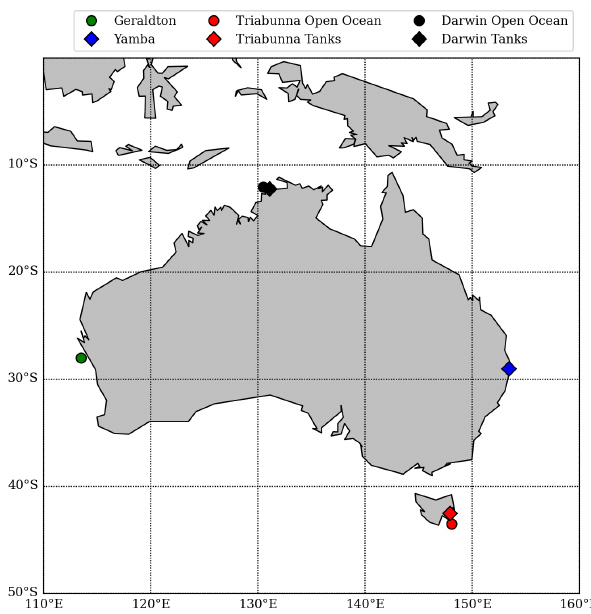
Figure 1. Locations of actual Asparagopsis farms in Geraldton, Tri- abunna, and Yamba and theoretical farms in